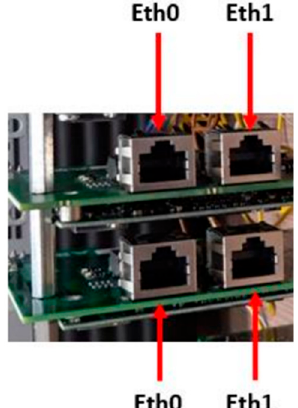
Figure 5. Main connections of the experimental system setup: 2 × Ethernet 10 / 100 BASE-T.